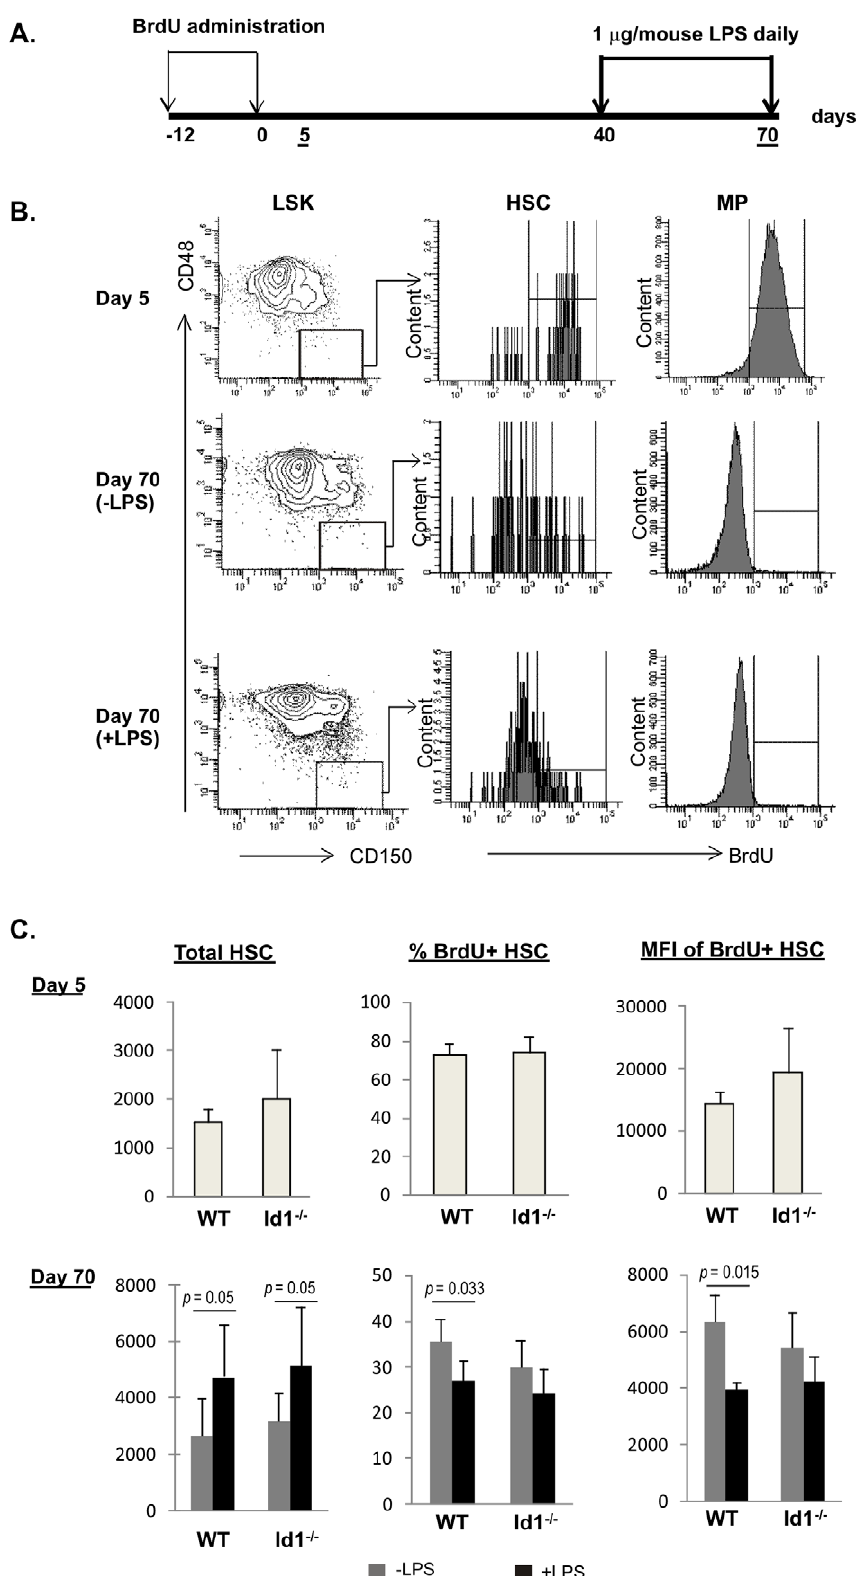
Figure 5. Label-retaining assay. (A) Experimental scheme. Time points (days) when actions were taken are labeled and those when mice were assayed are underlined. (B) FACS analysis of BrdU incorporation on Day 5 and Day 70. FACS plots of untreated and treated WT mice are shown as examples. BrdU incorporation in CD150 + CD48 2 LSK (HSC) and Lin 2 c-kit + Sca-1 2 myeloid progenitors (MP) populations are shown in histograms. BrdU